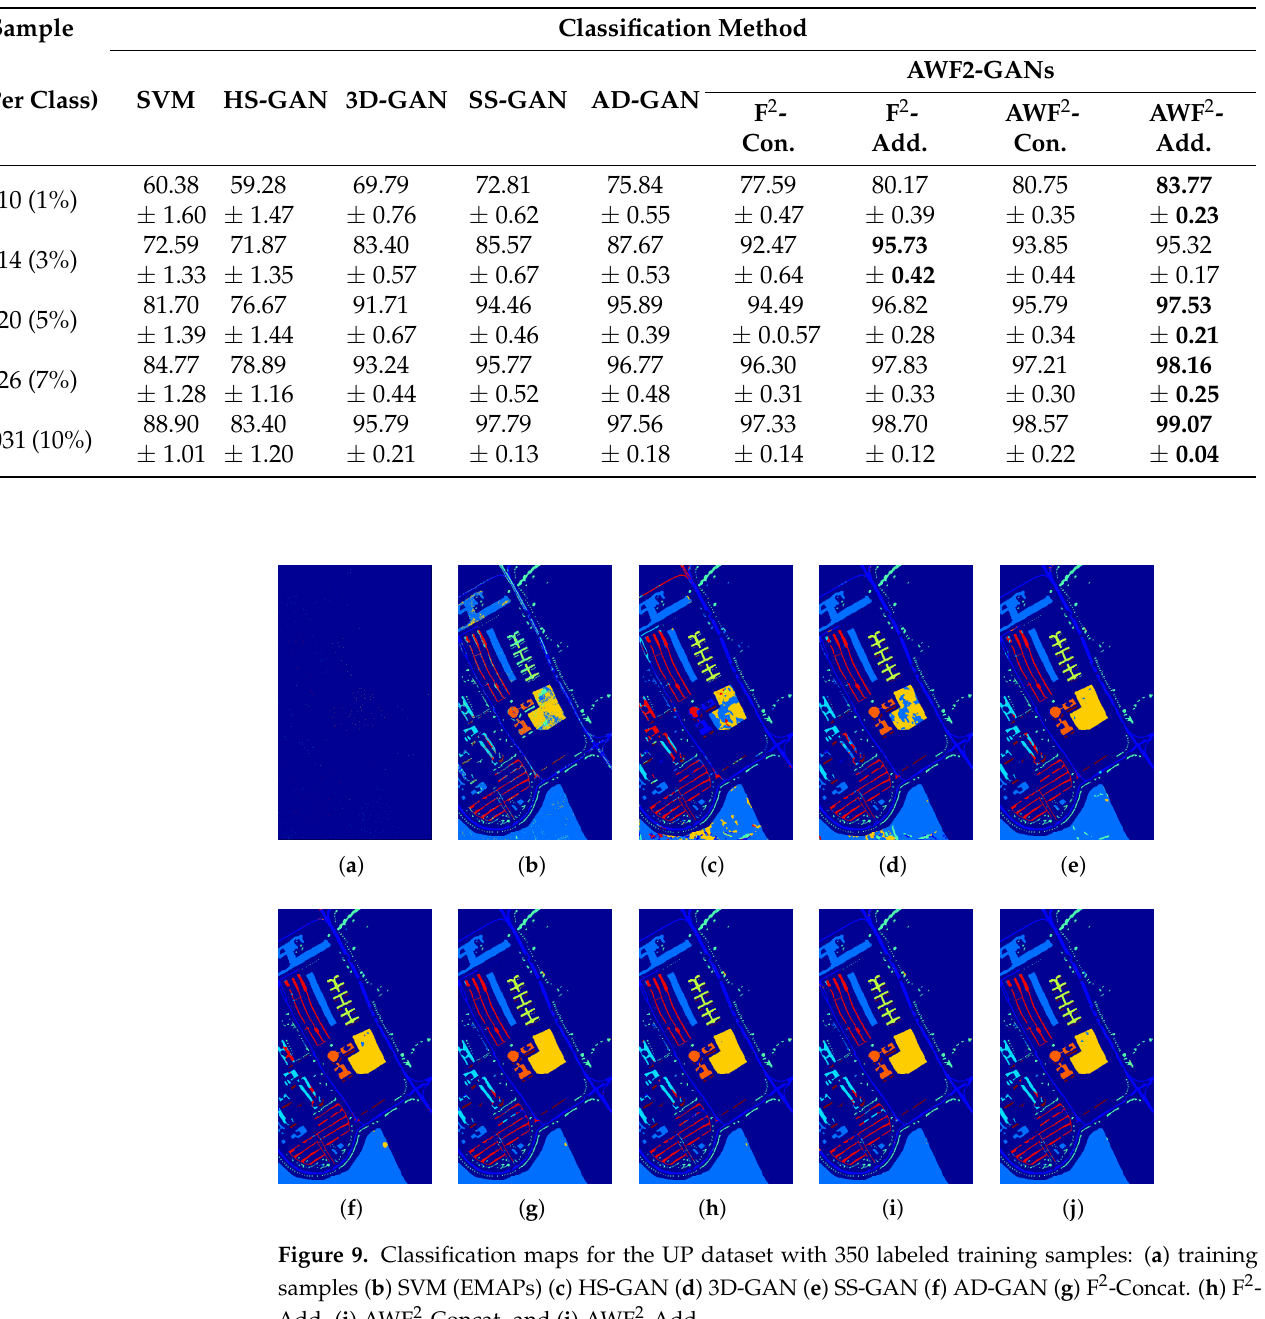
Table 4. The overall accuracy (OA) of classification methods on the IN dataset using various percentages of training samples. The best performances for each test case are in bold.